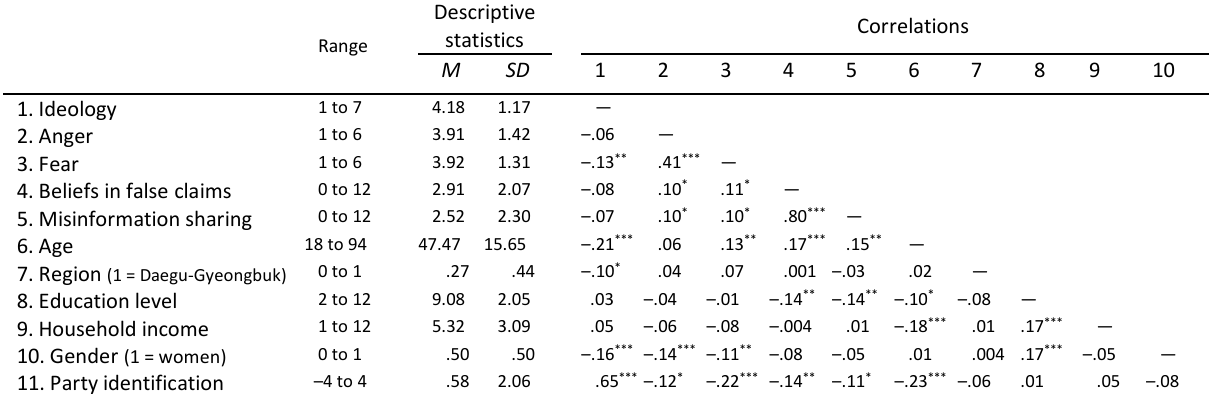
Table A. Descriptive statistics and intercorrelations (N =